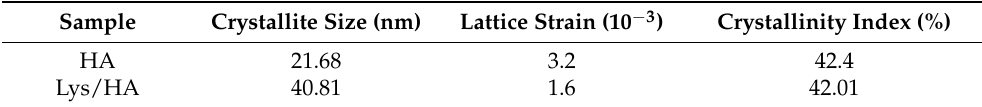
Table 1. Crystallite size, lattice strain, and crystallinity index of HA and Lys/Ha from W-H method.